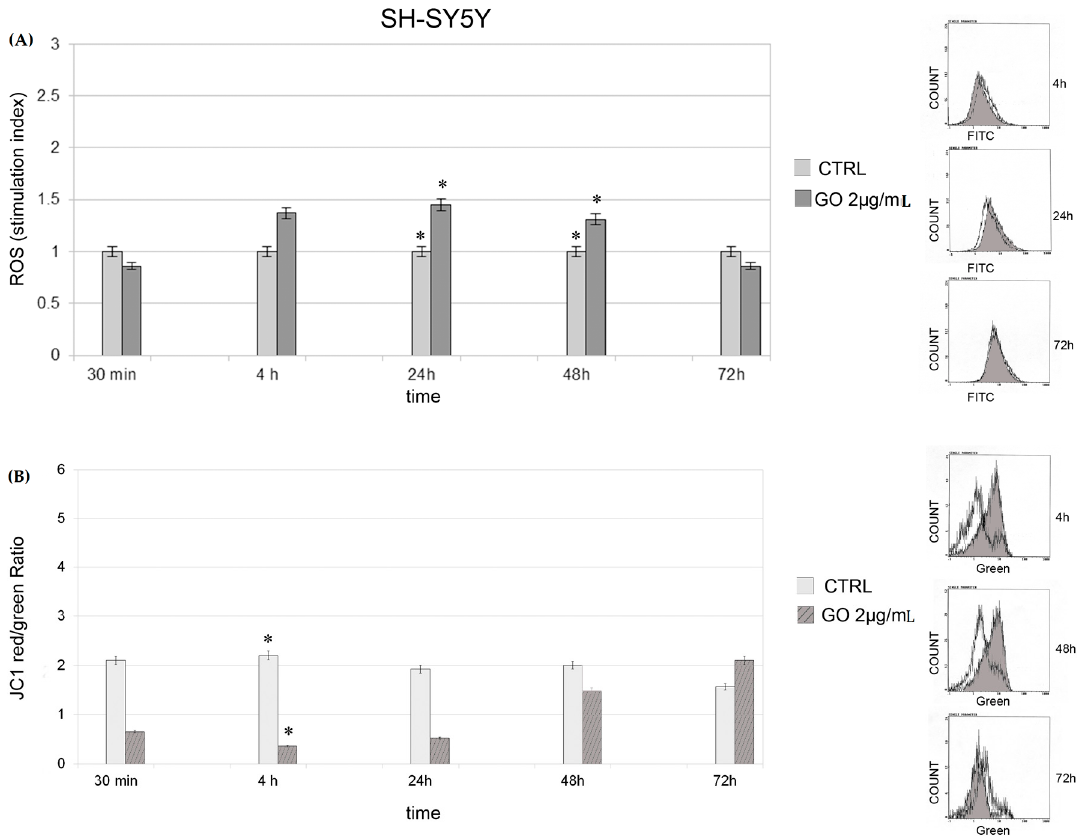
Figure 4. ROS production and JC1 dye in SH-SY5Y cells: ( A ) ROS production in SH-SY5Y cells at different times of GO exposure The mean fluorescence intensity was detected and expressed as stimulation index obtained by ratio between ROS levels in treated cells divided by ROS in control cells. Data are the mean ± SD of three different experiments. On the right of the panel, there are indicative fluorescence peaks of control cells and GO treated cells at indicated times. Grey peaks refer to GO treated cells. * p < 0.05 for each exposure condition compared to unexposed control (CTRL). ( B ) JC1 dye in SH-SY5Y cells at different times of GO exposure. Data are expressed as mean of red/green ratio of three different experiments ± SD. On the right of the panel, there are indicative peaks of green fluorescence (referring to depolarized cells) of control cells and GO treated cells at indicated times. Grey peaks refer to graphene treated cells. * p < 0.05 for each exposure condition compared to unexposed control (CTRL).